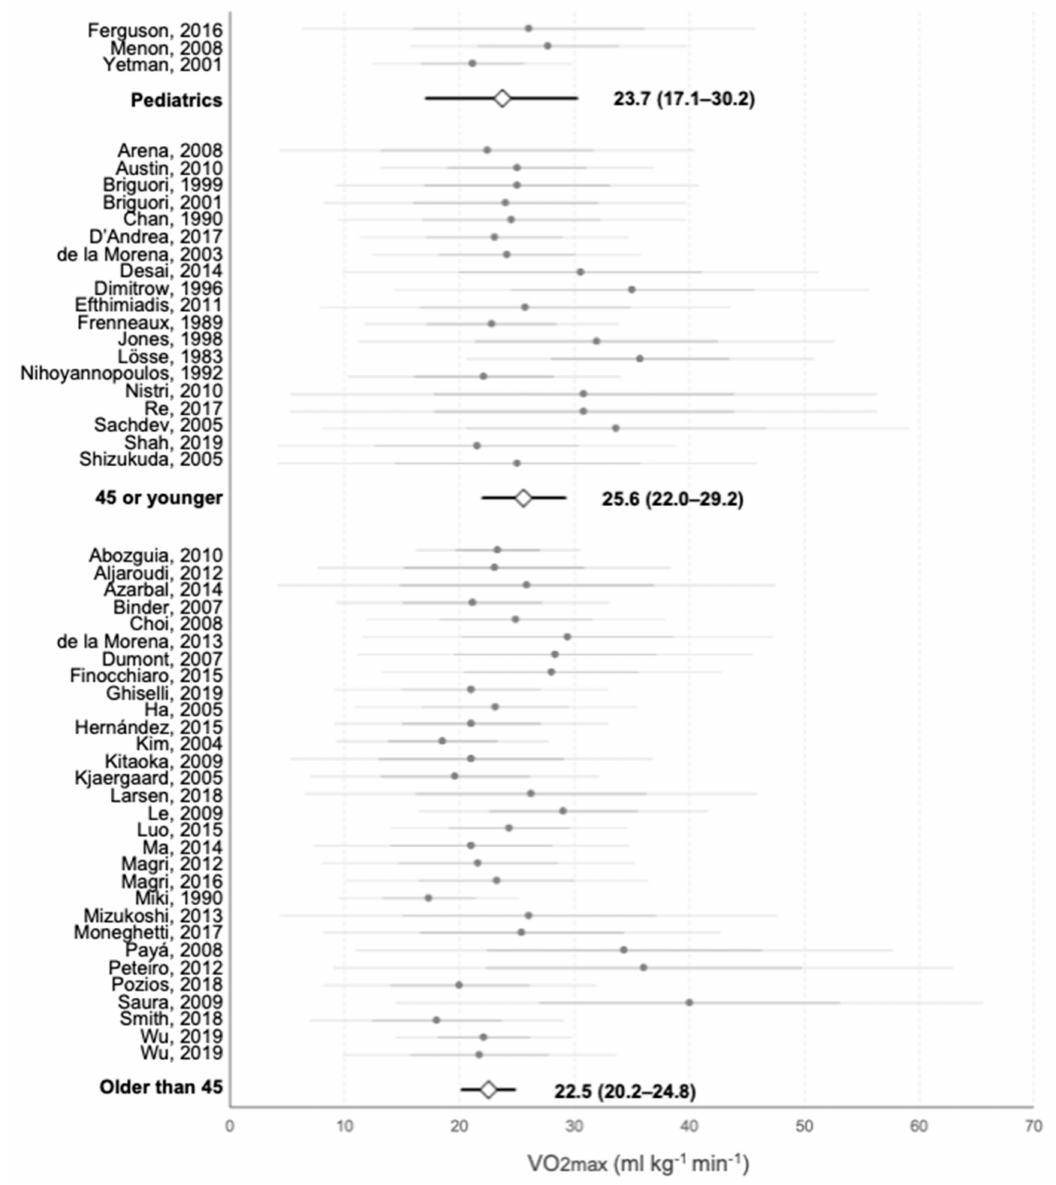
Figure 4. Meta-analysis of the VO2max reported on each study and average values for each age group. Grey points represent the average value of each individual study. Darker horizontal lines intersecting them represent the upper and lower value of the mean ± SD, and lighter horizontal lines show 95% CI. White rhombi intersected by a black line represent the mean VO2max and 95% CI of each age group as extracted from the meta-analysis. Numerical values of each subgroup are